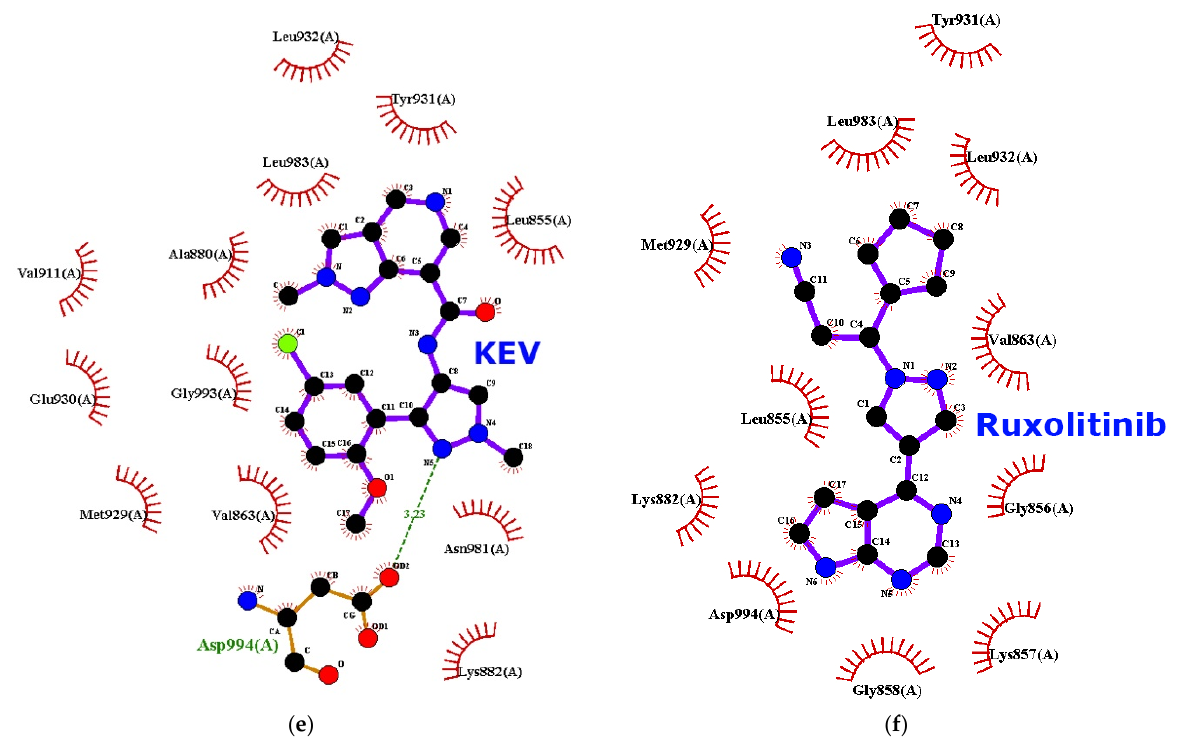
Figure 4. Interactions diagram of JAK1 kinase interactions with decernotinib ( a ), with KEV ligand ( b ), and with ruxolitinib ( c ); JAK2 kinases with decernotinib ( d ), with KEV ligand ( e ), and with ruxolitinib ( f ) (Supplementary materials, Figures S7–S12).